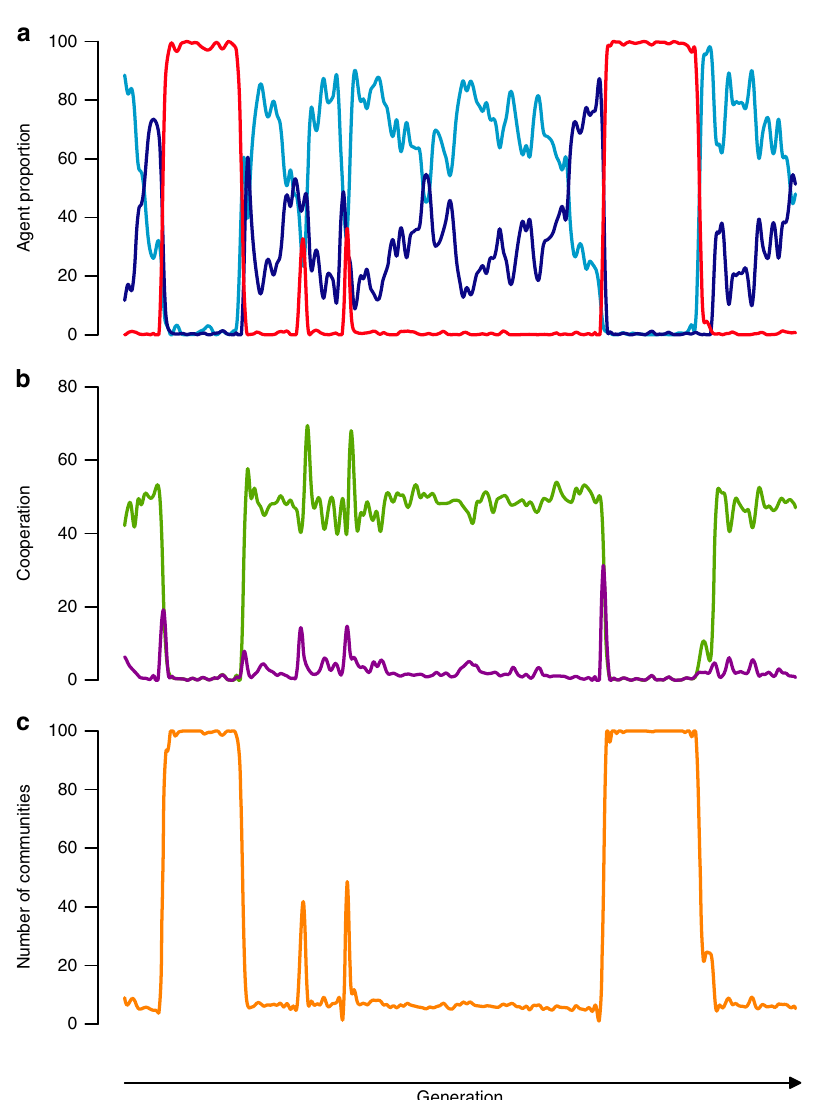
Fig. 3 Fission – fusion dynamic of reputation-based cooperation. As the number of Heider agents (dark blue line) in a population of friend-focused agents (light blue line) increases, the risk of invasion by free-riders (red line) increases ( a ). A population of free-riders in turn gets invaded by friend-focused agents. Following this dynamic, cooperation (green line) and successful exploitation (magenta line) fl uctuates ( b ) and community structures emerge and dissolve as a function of the population dynamic ( c ) — based on n = 100, 4 × 10 5 iterations, i = 10, c = 1, b = 4, r =